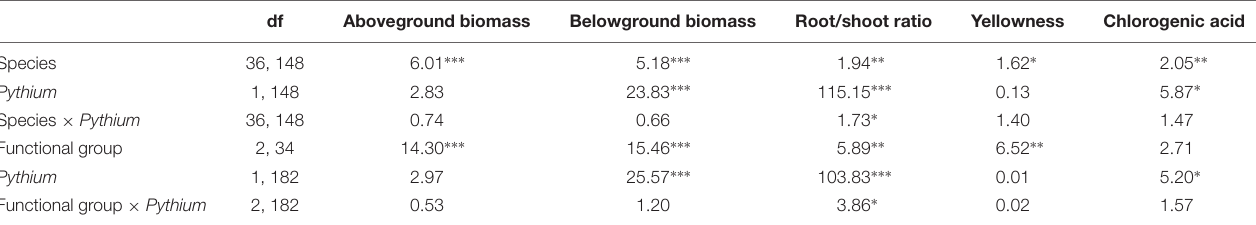
TABLE 2 | Overall effects of identity and functional group of the conditioning plant species, and of Pythium addition on aboveground biomass, belowground biomass, root/shoot ratio, proportion of yellow leaves and leaf chlorogenic acid concentrations in chrysanthemum. df Aboveground biomass Belowground biomass Root/shoot ratio Yellowness Chlorogenic acid Species 36, 148